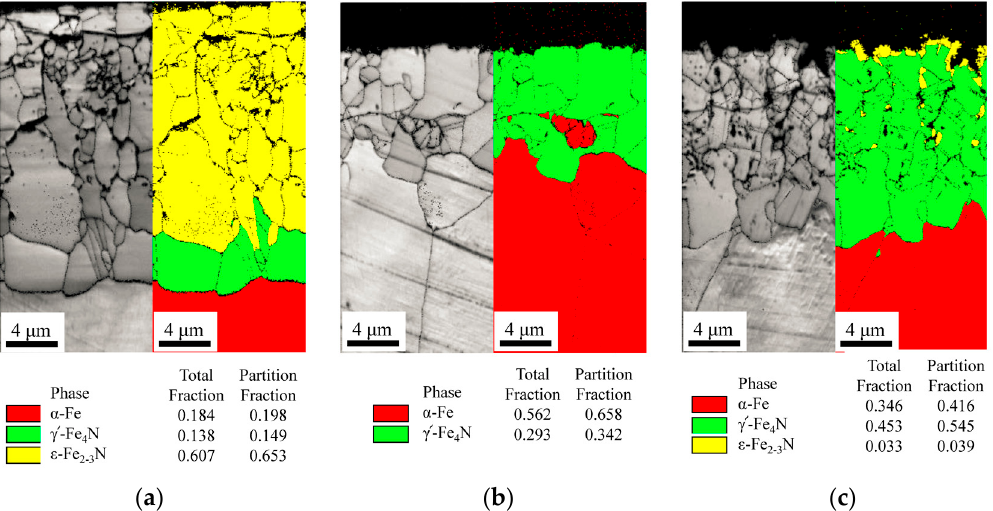
Figure 6. (Right side) phase map from the cross-sectional gas-nitrided pure iron, with the phase relevant color coded map, α -Fe or α -Fe[N] (red), γ ’ phase (green), ε phase (yellow), (Left side) Cross-sectional SEM images from EBSD area: Gas-nitrided pure iron with ( a ) 1.4, ( b ) 0.38 and ( c ) 1st stage: 1.4 and 2nd stage: 0.38 of nitriding potential at 570 °C for ( a ), ( b ) 4 h and ( c ) 1st stage: 4 h and 2nd stage: 2 h.